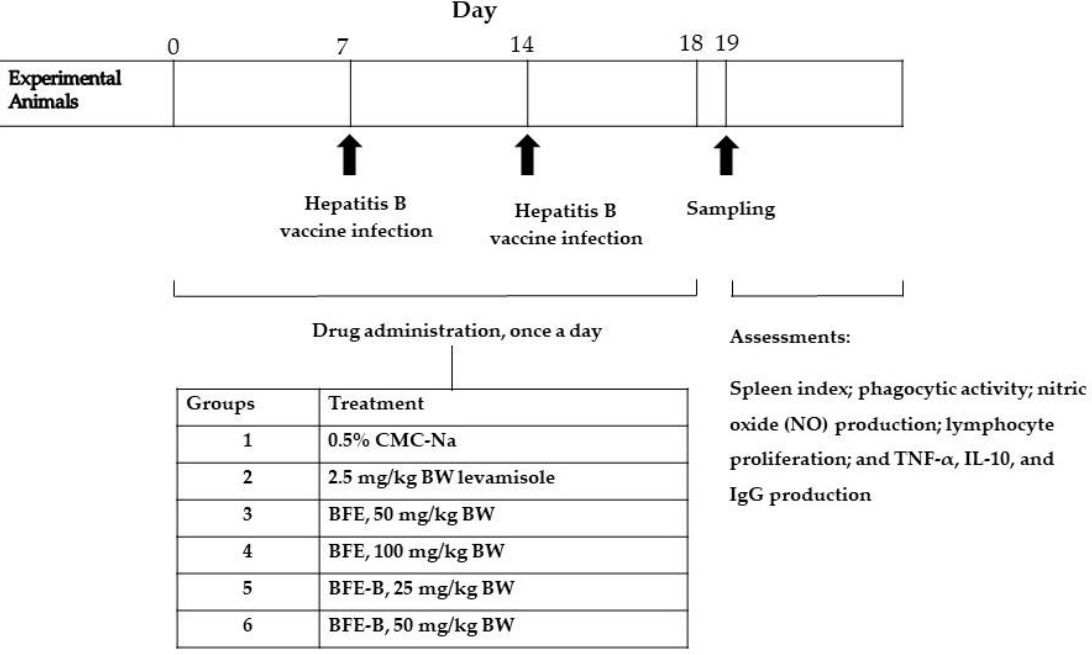
Figure 2. Experimental animals design for experimental analysis.